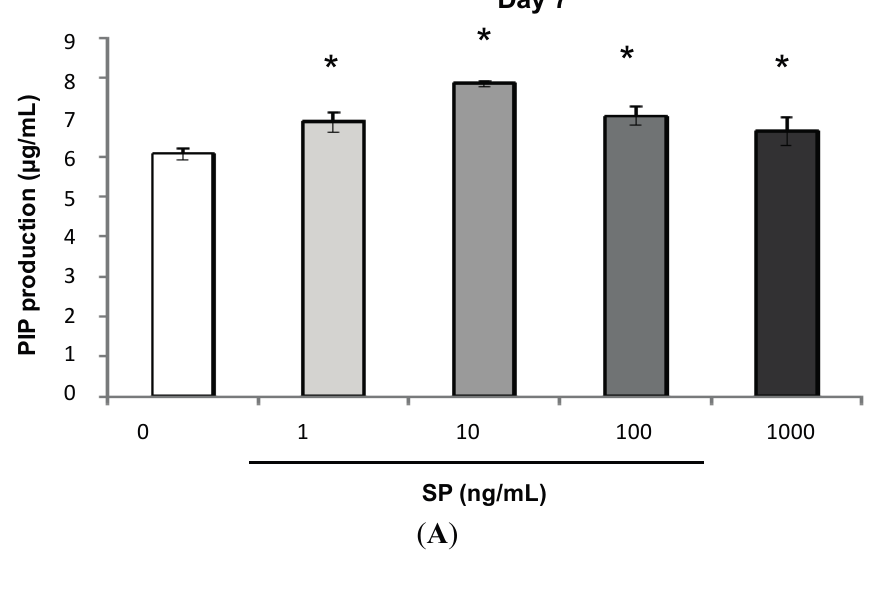
Figure 3. Effect of SP on the production of Procollagen Type 1 C -Peptide (PIP) and Osteocalcin (OCN). After the MSCs reached confluence, the culture medium was replaced with osteogenic medium containing SP (0, 1, 10, 100 or 1000 ng/mL) and the cells were cultured for 7 or 14 days. ( A ) day 7, * p < 0.05, vs. SP (0 ng/mL); and ( B ) day 14, * p < 0.05, vs. SP (0